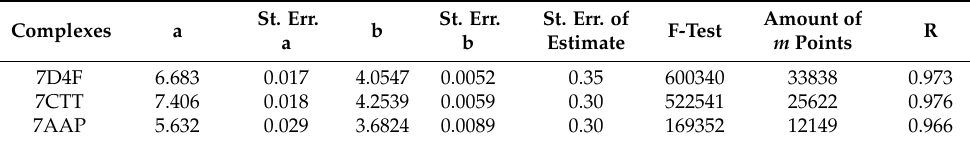
Table 1. Values of the a- and b-parameters, Standard Error for a-and b-parameters (St. Err.), Standard Errors of estimate, Fisher’s criterion (F-test), total points and the correlation coefficient R. St. Err. St. Err. St. Err. of Amount of Complexes a b F-Test R m Points a b Estimate 7D4F 6.683 0.017 4.0547 0.0052 0.35 600340 33838 0.973 7CTT 7.406 0.018 4.2539 0.0059 0.30 522541 25622 169352